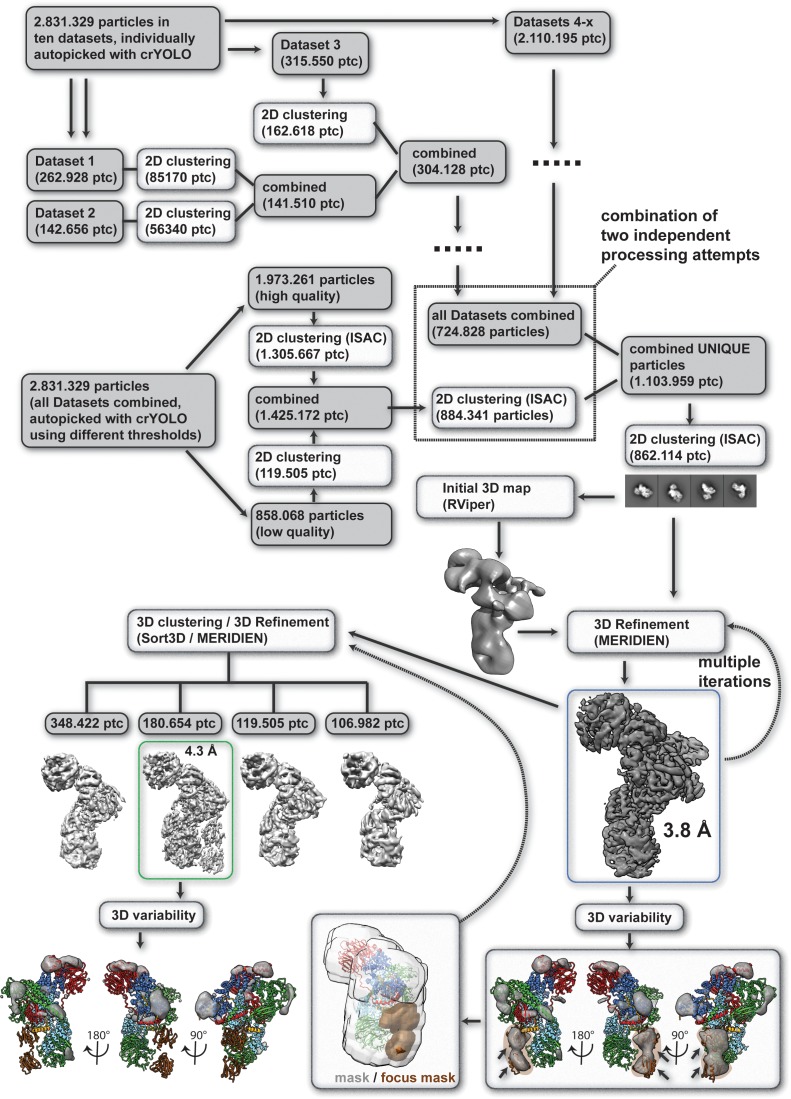
Single particle processing workflow for structure determination of the human core BBSome.The map that was used for modelling BBSome subunits 1,4,8,9 and 18 is marked with a blue box, and the map that was used for BBS5 is marked with a green box.